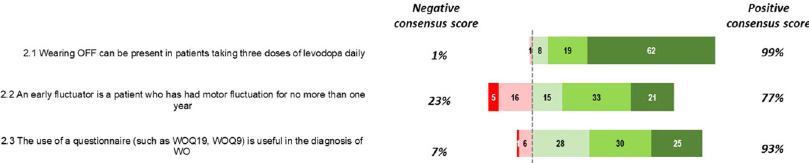
Fig. 2 Delphi questionnaire results: topic 2 “ Introduction to fl uctuations ” . Numbers in the colored bars are the total number of votes received for each level of disagreement/agreement (1, extremely disagree; 2, disagree; 3, agree; 4, mostly agree; and 5, extremely agree). The “ negative consensus score ” and the “ positive consensus score3 are percentage.